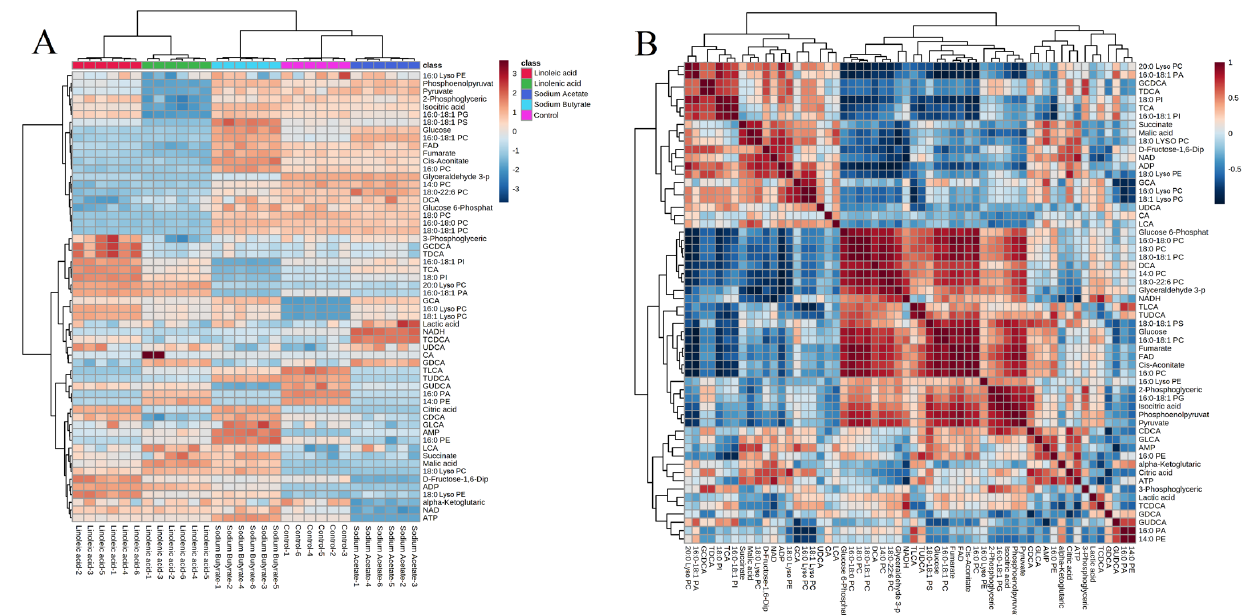
Figure 6. Heatmap ( A ) and correlation analysis ( B ) based on targeted metabonomics.